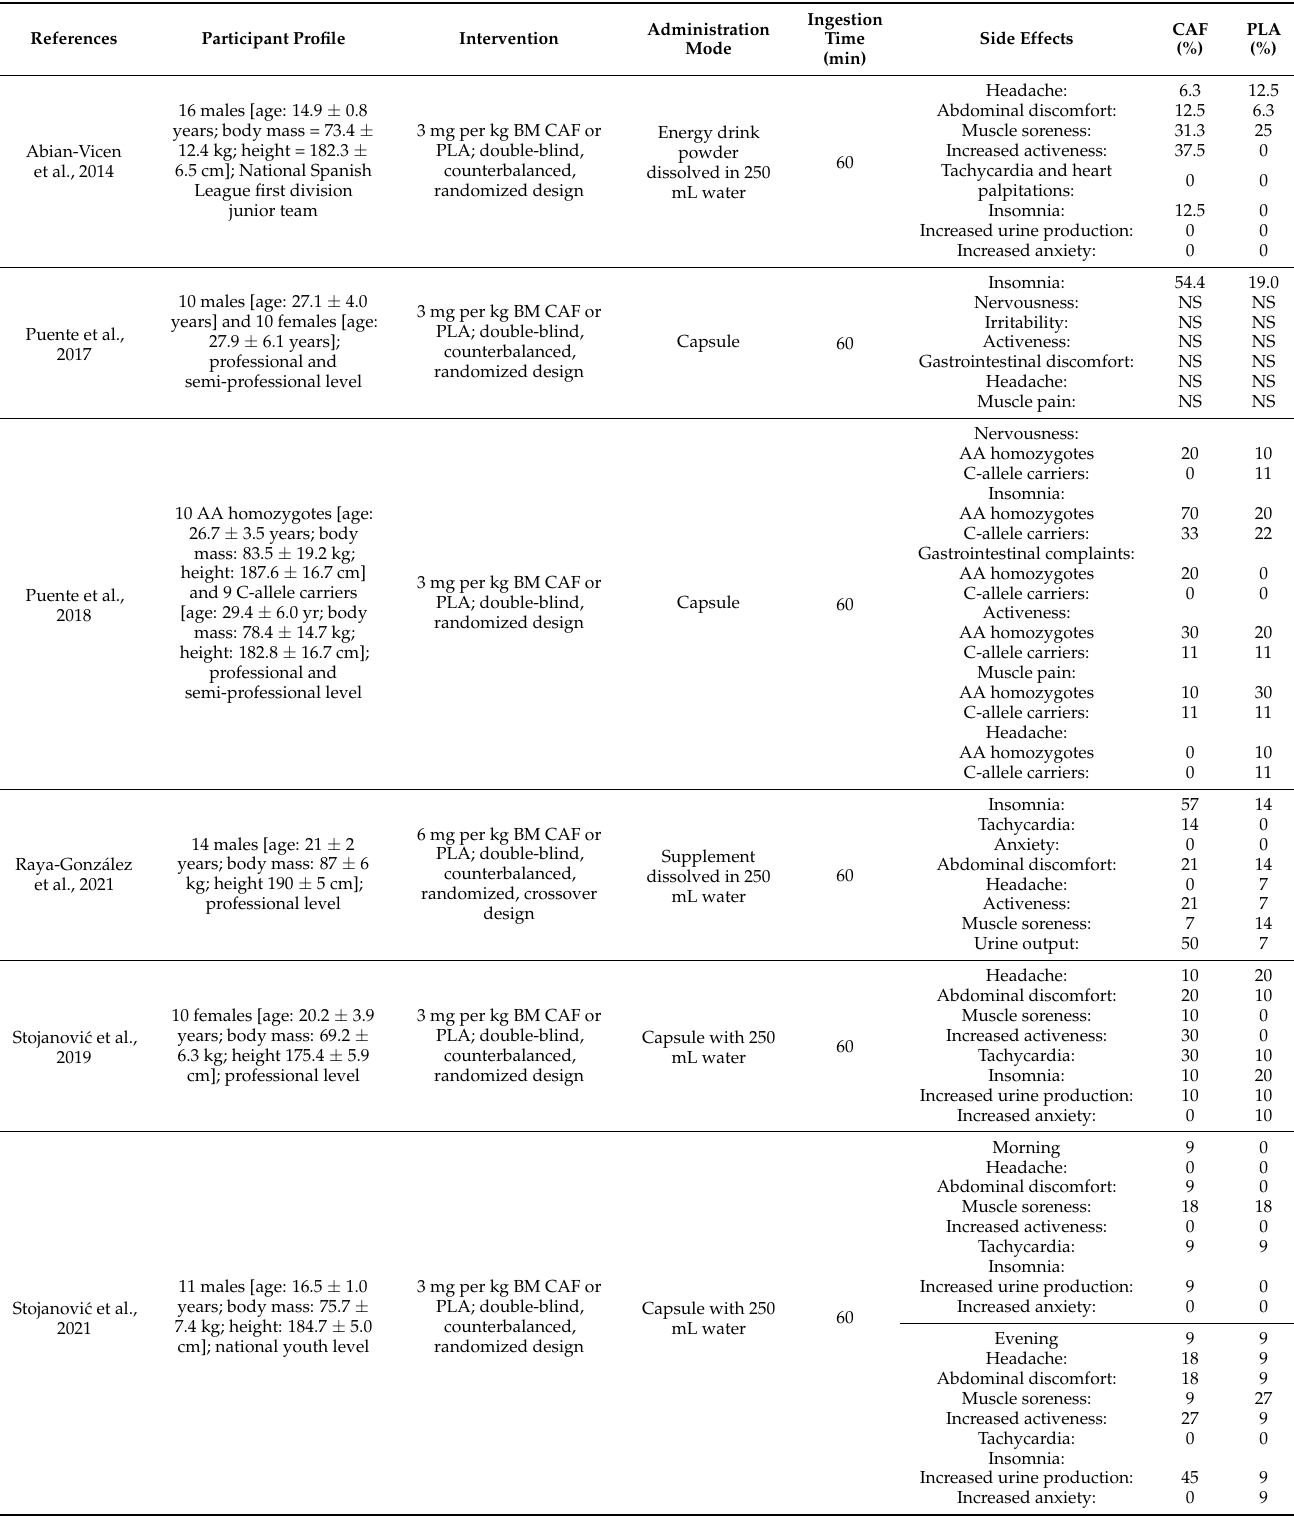
Table 6. Side effects of caffeine during basketball testing